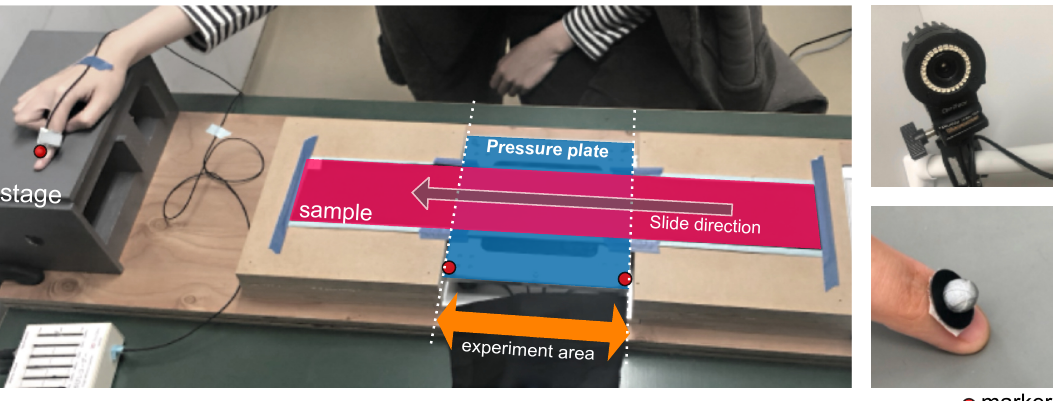
Figure 3. Experimental setup . Starting from the stage, the participants slid the index finger over the sample from left to right (slide direction) in a smooth and continuous motion. On the index finger, a motion capture marker and a skin vibration sensor were attached to measure the speed and the vibration signal, respectively. Beneath the sample, a pressure plate was used to measure contact force. Two markers on the pressure were defined as the effective experimental areas where all the parameters were